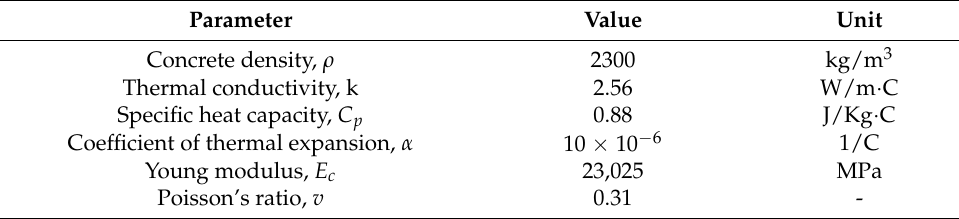
Table 1. Concrete parameters used in the FE